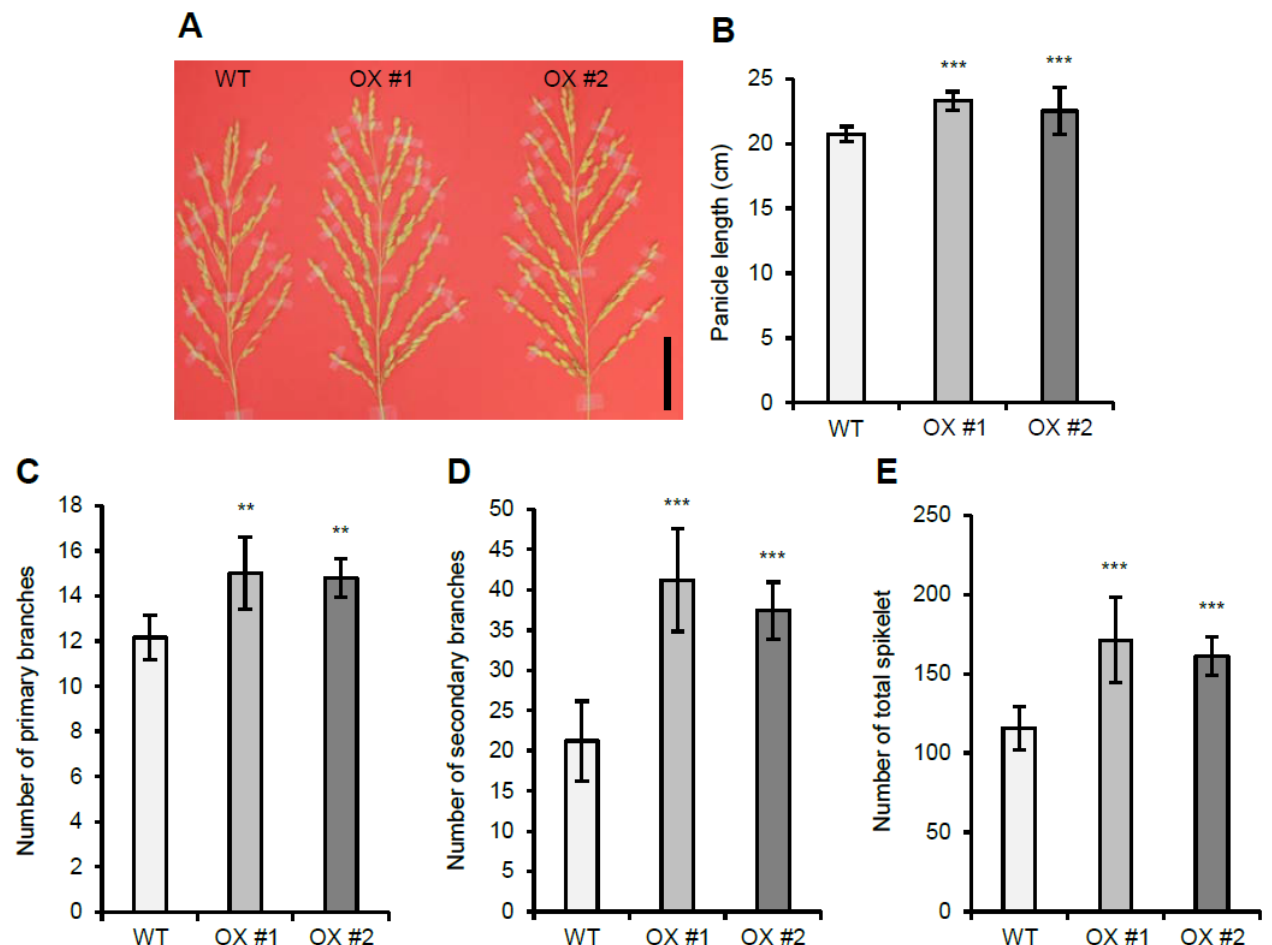
Figure 4. Panicle development in wild-type (WT) and OsVIL1 overexpression (OX) plants. ( A ) Panicle phenotype of WT and OsVIL1 OX transgenic lines. Bar = 5 cm. ( B ) Main panicle lengths. ( C ) Number of primary branches on the main panicle. ( D ) Number of secondary branches on the main panicle. ( E ) Total number of spikelets on the main panicle. The error bars indicate the standard deviations, n = Statistical significance is indicated by *** ( p < 0.001), ** ( p < 0.05).